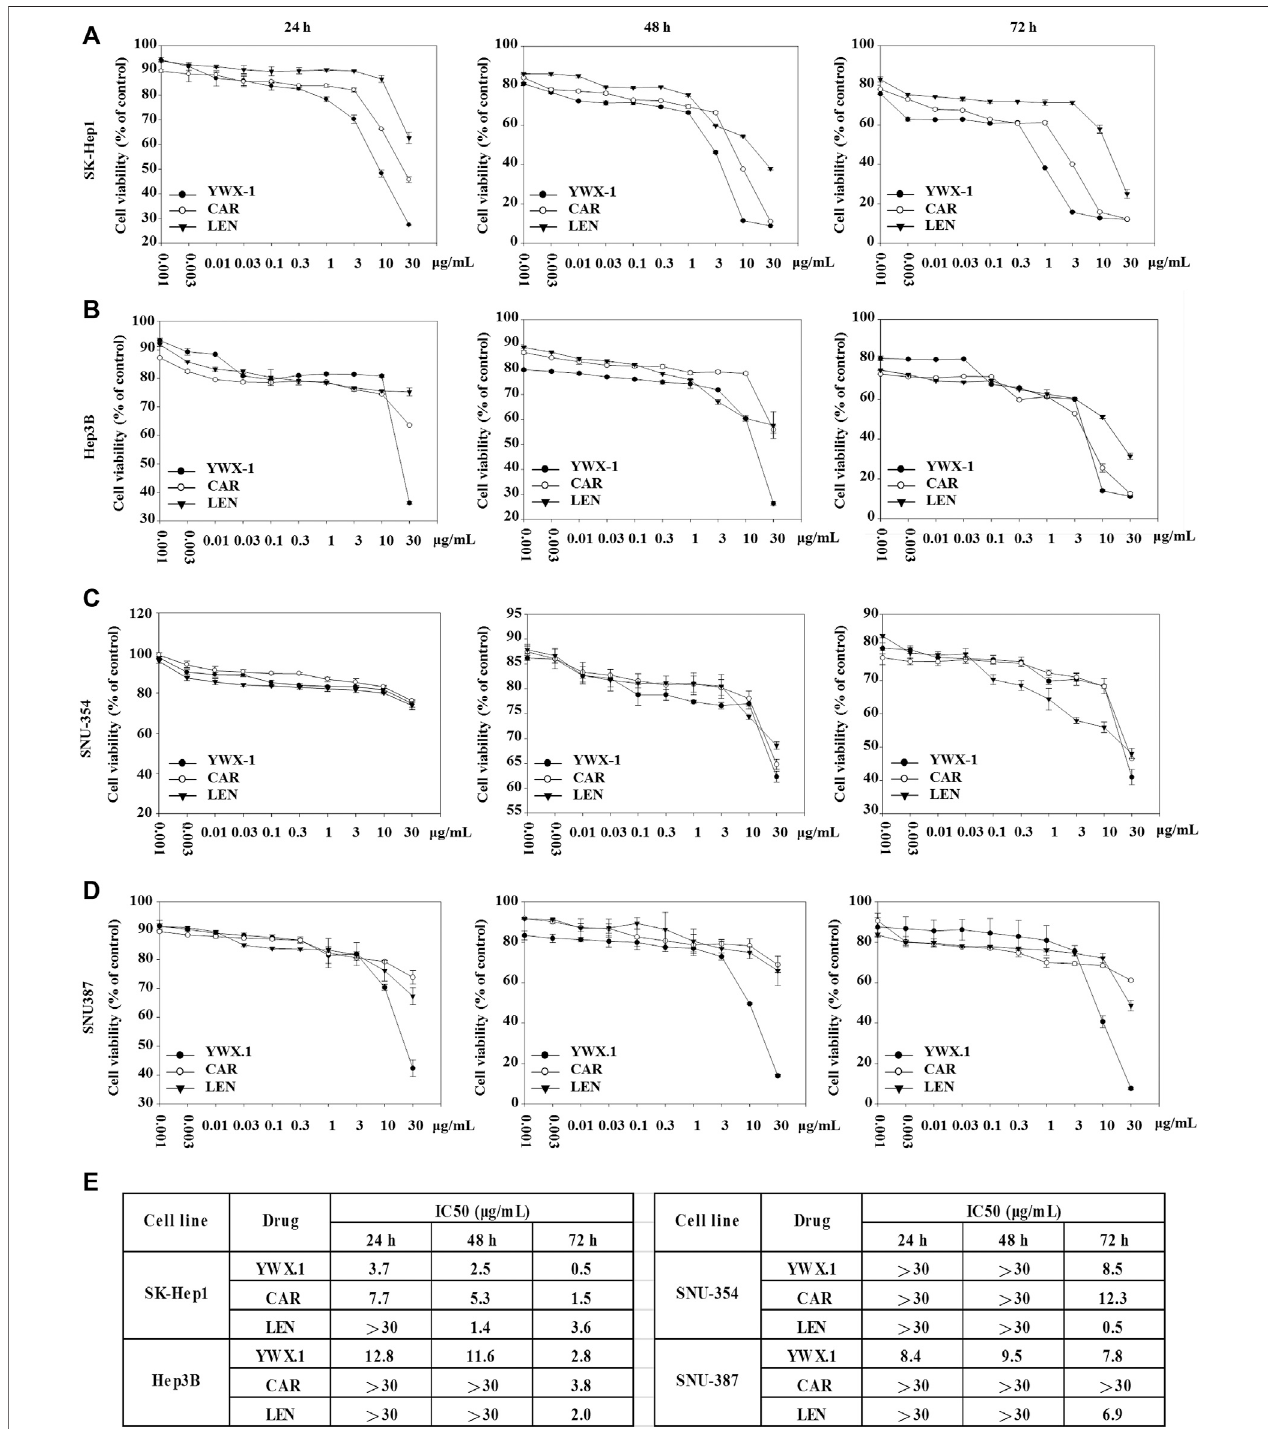
FIGURE 1 | Carrimycin (CAR) and monomeric isovalerylspiramycin I (YWX-1) inhibit the viability of hepatocellular carcinoma cells. The hepatocellular carcinoma cells (A) SK-Hep1, (B) Hep3B, (C) SNU-354, and (D) SNU-387 were incubated with various concentrations of carrimycin and monomeric isovalerylspiramycin I at 24, 48,72 h,andtheirviabilitywerethendeterminedbyMTTassay. (E) IC50valueofcarrimycin,monomericisovalerylspiramycinI,andlenvatinibinSK-Hep1,Hep3B,SNU- 354, and SNU-387 cells.